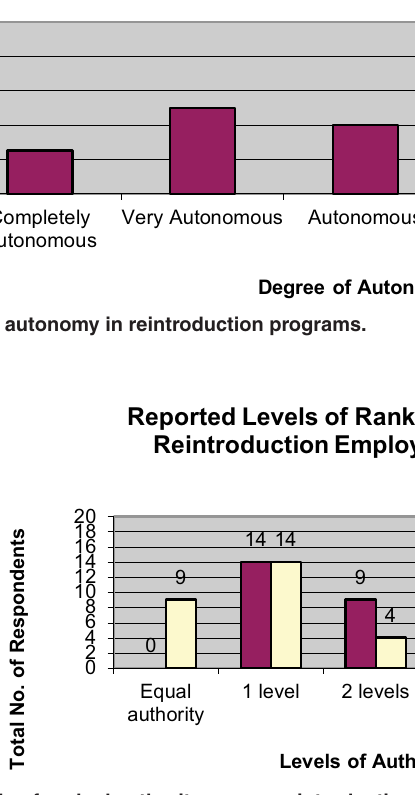
Figure 6. Reported levels of ranked authority among reintroduction employees and